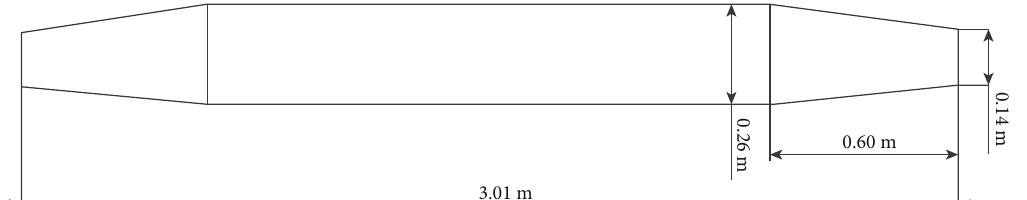
Figure 8: Wing shape and dimensions.